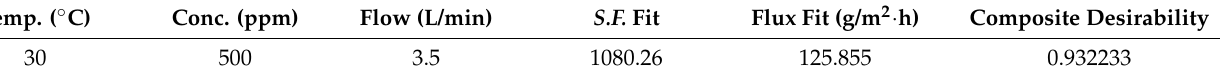
Table 6. Response optimization of toluene flux and S.F. for toluene–water solution.